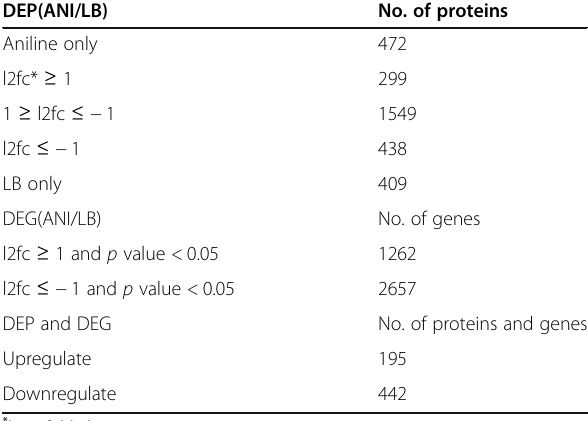
Table 2 Number of differentially expressed genes and proteins according omics-analysis of Delftia sp.